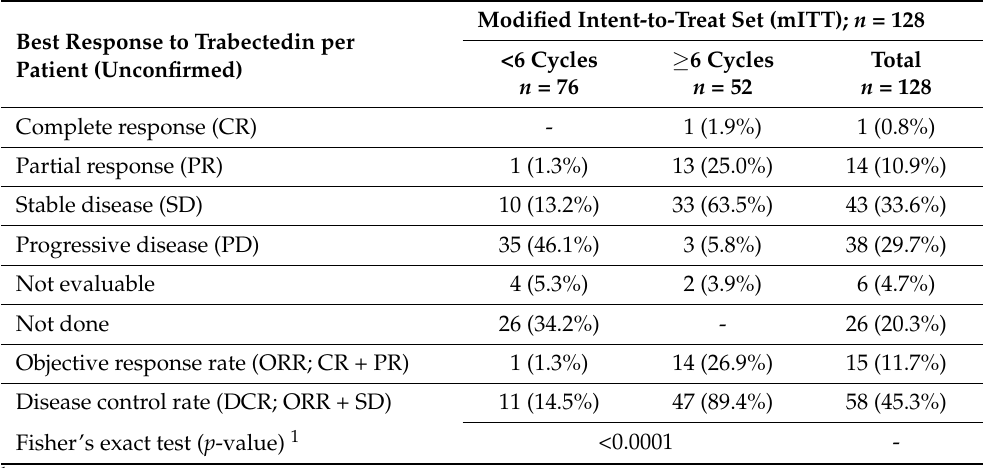
Table 4. Best response rate according to investigator assessment by number of treatment